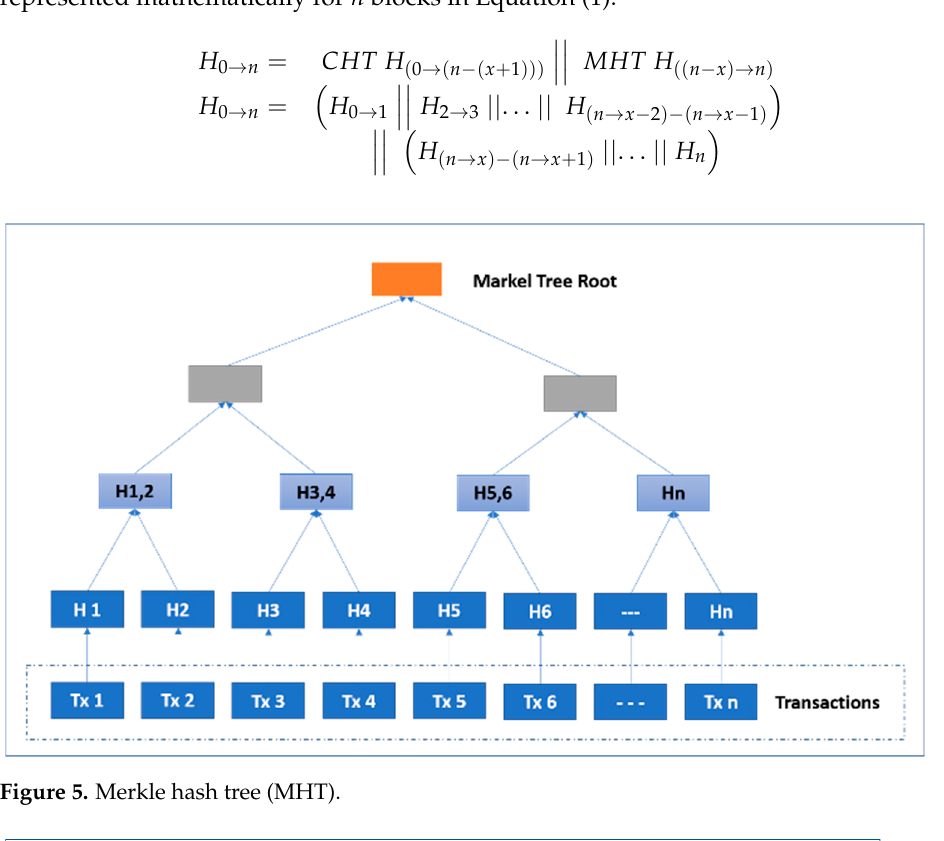
Figure 5. Merkle hash tree (MHT).